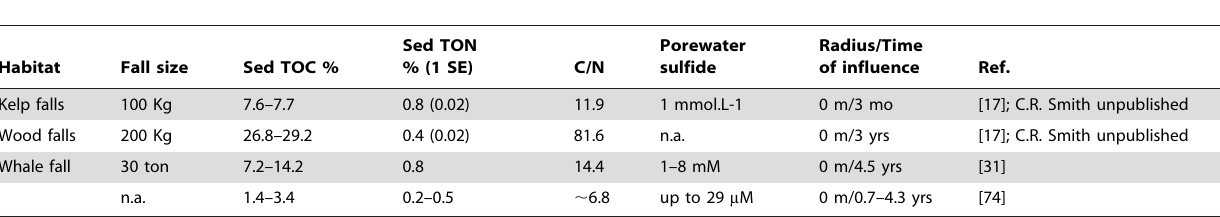
Table 2. Sediment organic content and maximum sulfide for kelp-, wood- and whale-falls. consumed by infauna living in microbial-mat and carbonate